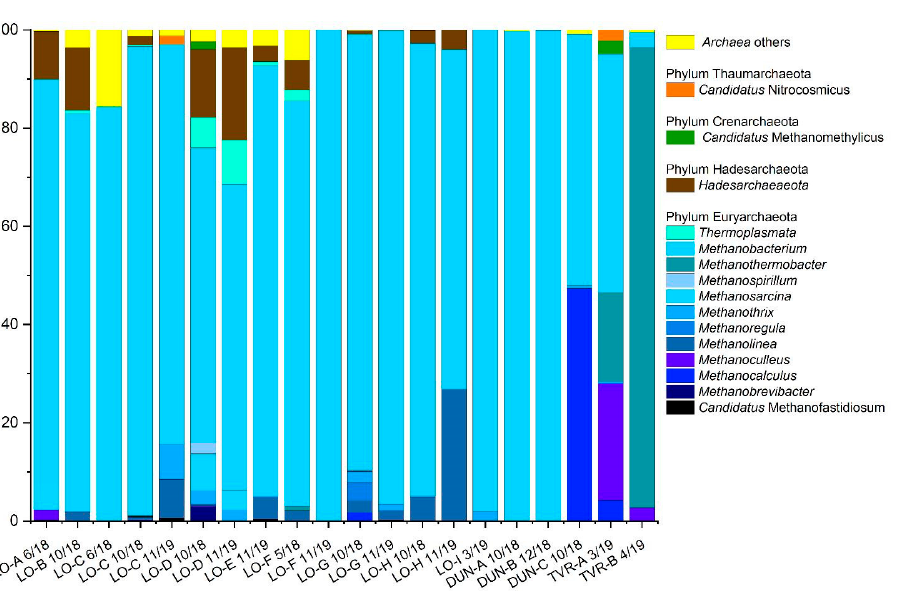
Figure 4. Selected metabolic groups predicted using the database of functional annotations of prokaryotic organisms, FAPROTAX.